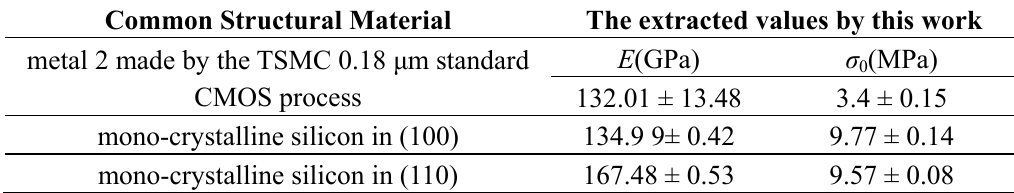
Table 9. The extracted results for common structural